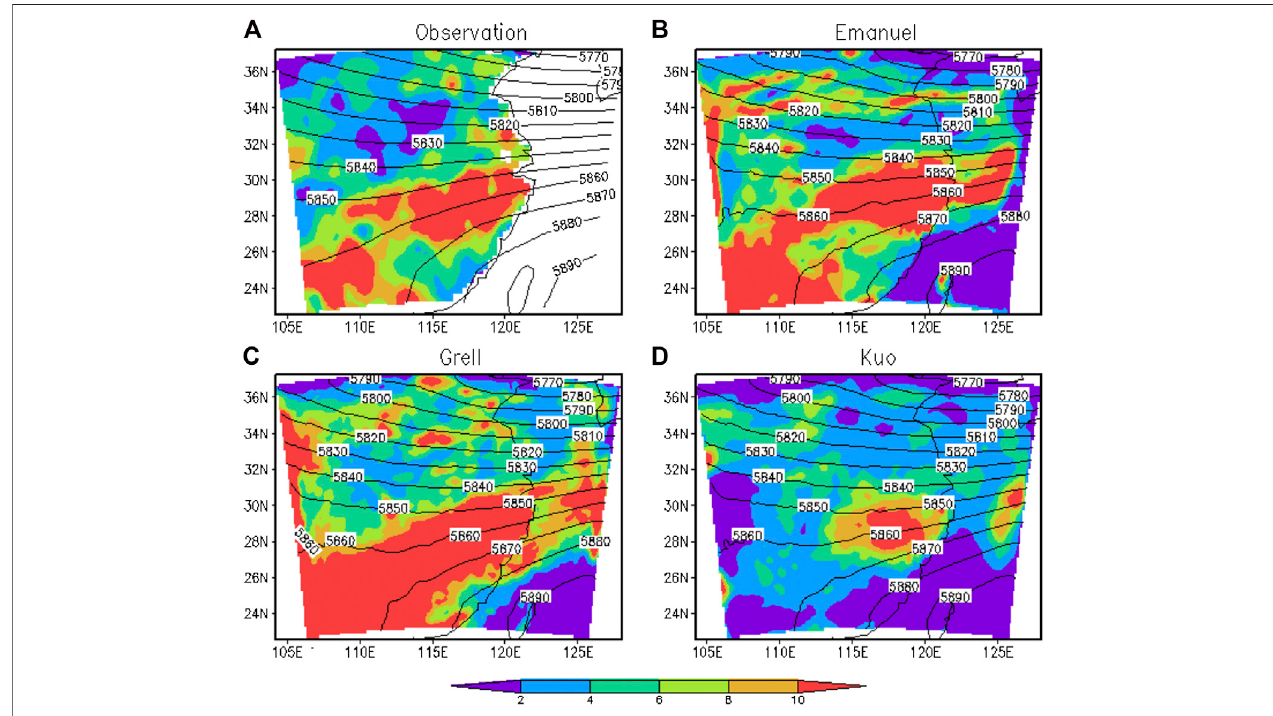
FIGURE 11 | Evolution of interdecadal components of the convergence index (black line with hollow circles) and monsoon index (green line with solid circles).